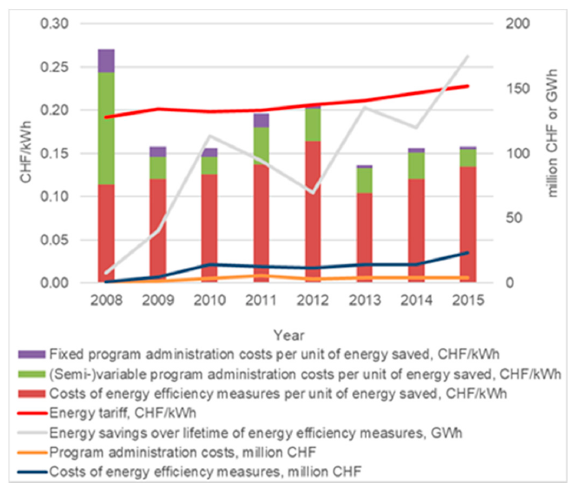
Figure 2. EEP in the Swiss canton of Geneva (éco21, electricity savings only): Energy savings and expenditure on energy efficiency measures and program administration in total and per unit of energy saved (results of updated analysis formerly published by Yushchenko et al., 2017 [45] and Freyre, 2019 [46]) (1 CHF = 1.01 USD = 0.899 EUR in 2019; OFX, 2020).